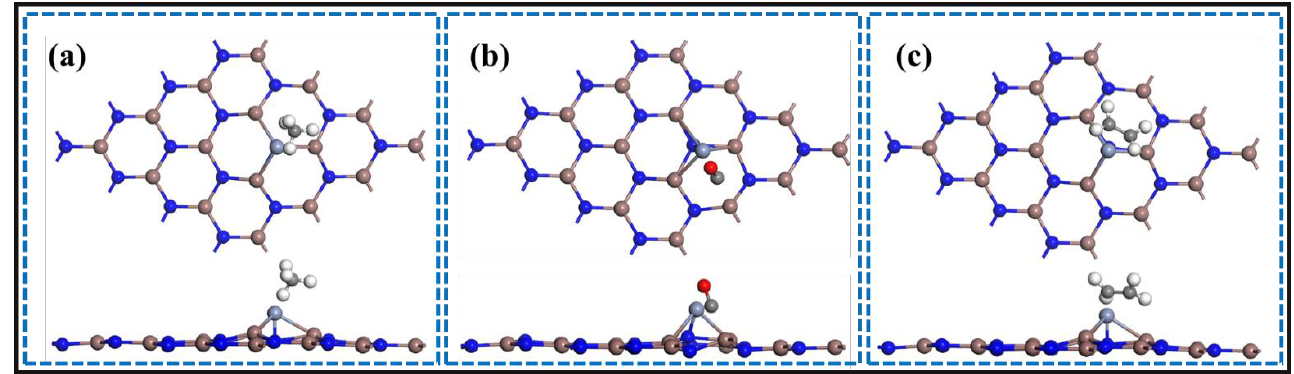
Figure 3. Geometric construction of ( a ) Cr-InN/CH 4 , ( b ) Cr-InN/CO, and ( c ) Cr-InN/C 2 H 4 adsorption systems.